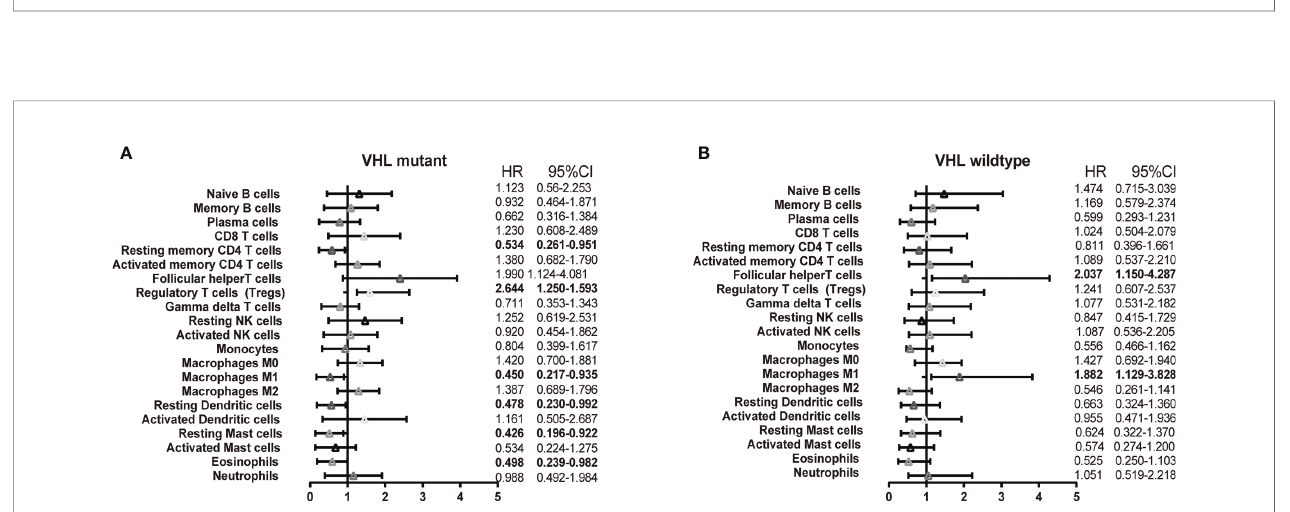
FIGURE 7 | Subgroup overall survival analyses of VHL mutant. The prognostic effect of 22 immune cell subsets by VHL mutant (A) and wild type (B) .